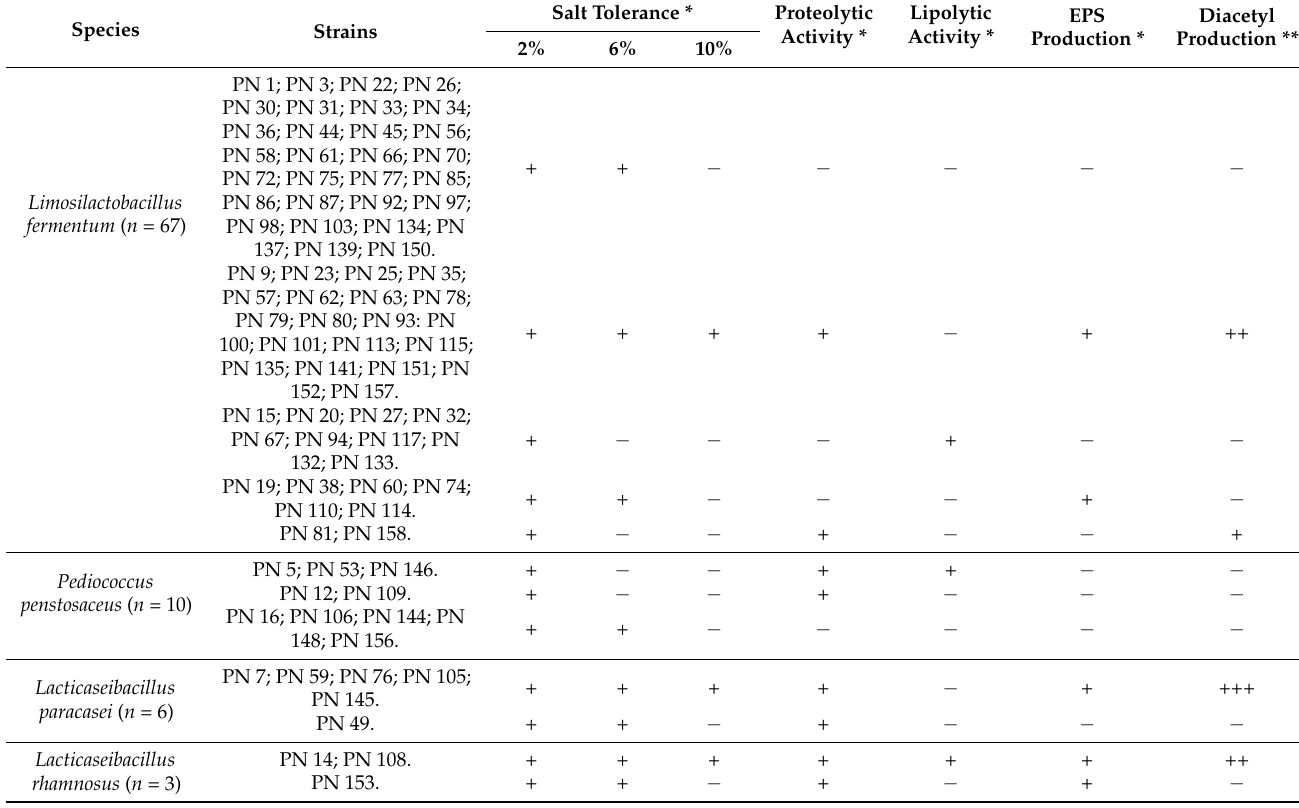
Table 2. Salt tolerance, proteolytic and lipolytic activities, exopolysaccharides (EPS) and diacetyl production exhibited by the NSLAB strains isolated from artisanal semi-hard Provola dei Nebrodi PDO (PN) cheese samples. Salt Tolerance * Proteolytic Species Strains Activity